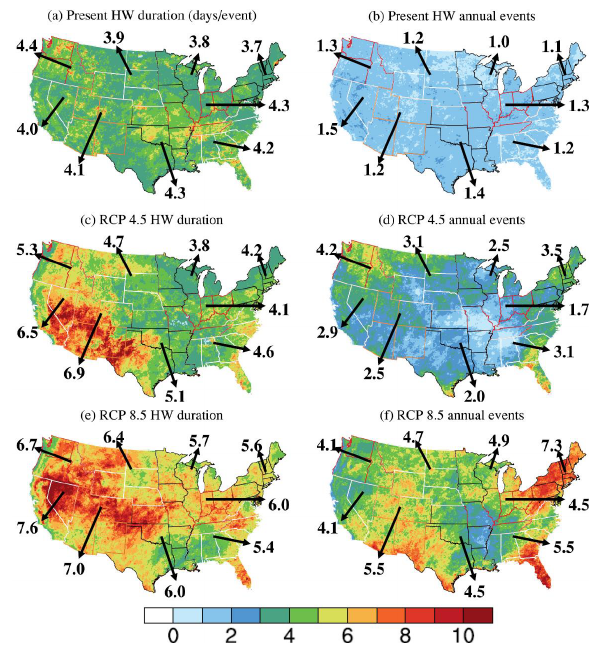
Fig. 7. The heat wave duration and frequency derived from the daily maximum temperature simulated by WRF 3.2.1. The state boundary was labeled with different colors to distinguish different regions as shown in Fig. 1. The numbers next to the arrows represent the regional mean heat wave duration or frequency